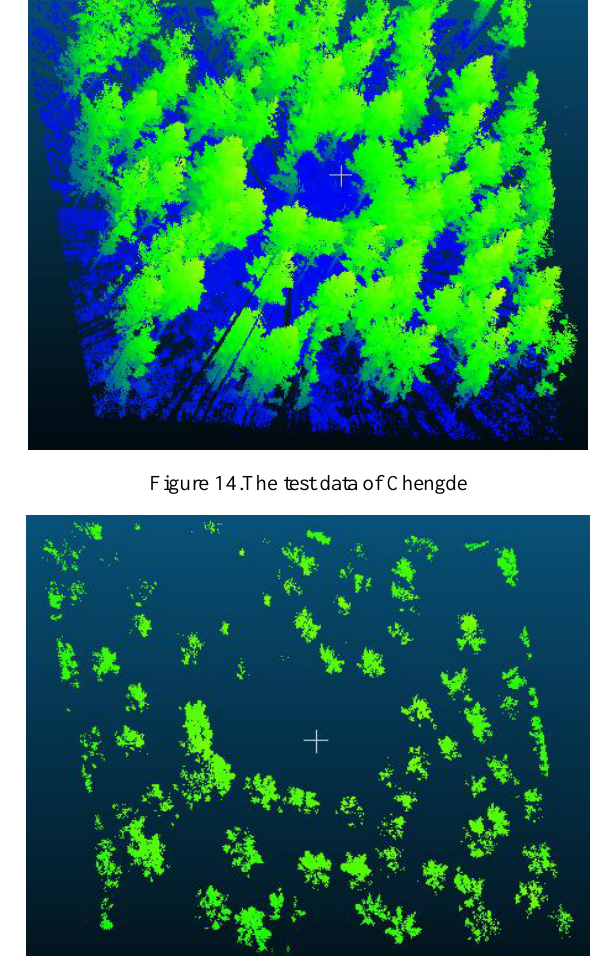
Figure 15.The extraction of non-ground seed points using CSF in the measured area by setting cloth resolution of